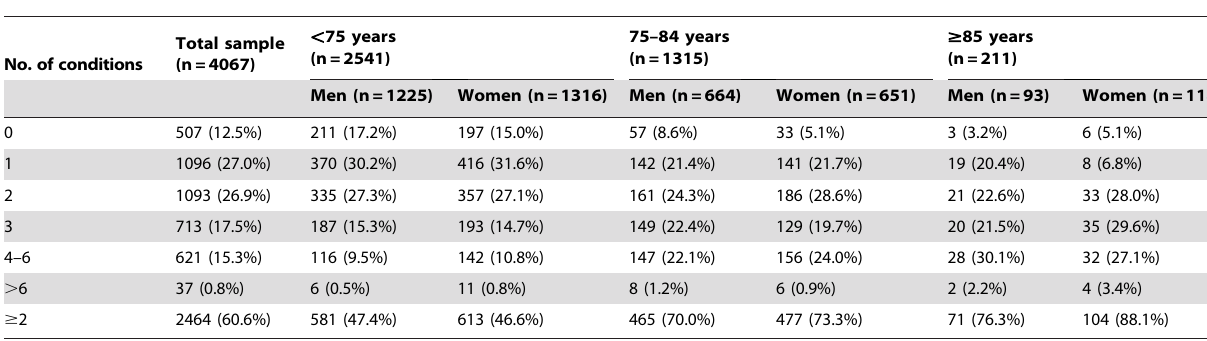
Table 3. Number of conditions stratified by age group and sex.